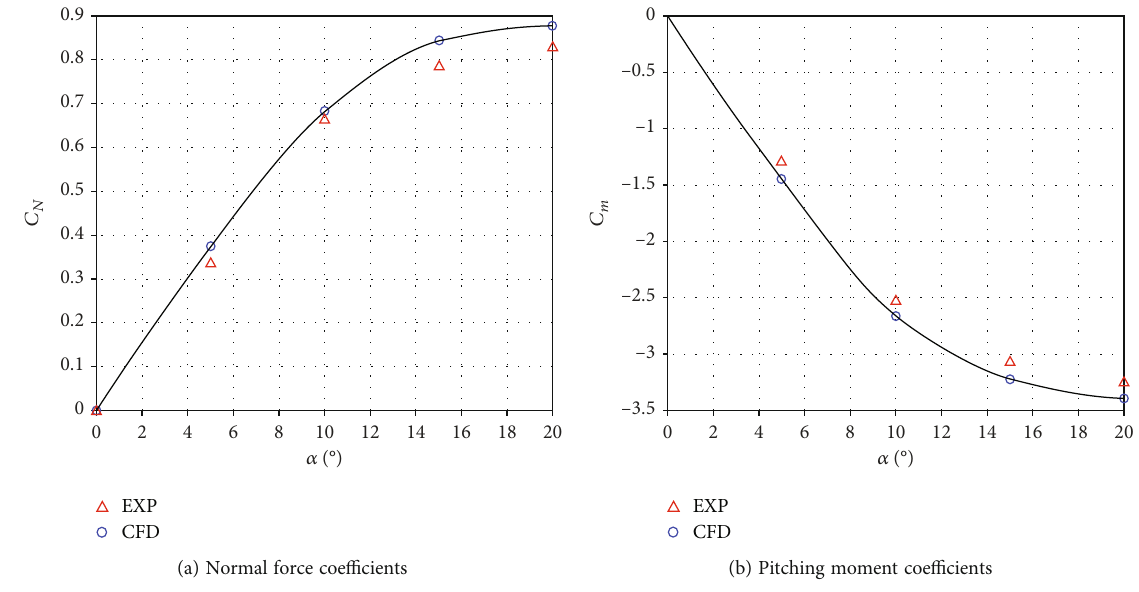
Figure 8: The CFD numerical calculation and experimental results of the grid tail